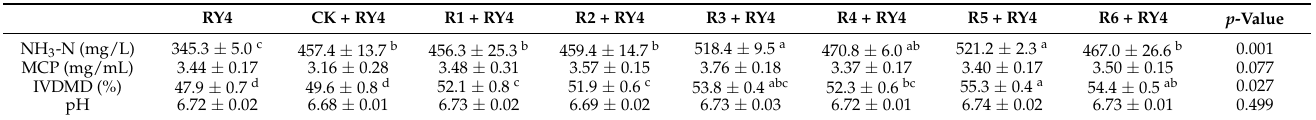
Table 6. In vitro fermentation parameters.